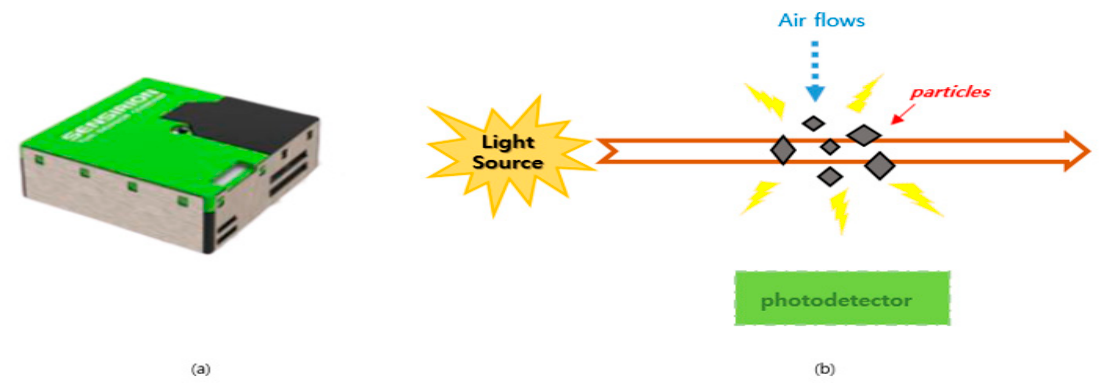
Figure 4. ICT-Particulate Matter Sensor (SPS 30), ( a ) optical sensor structure, ( b ) principle of optical sensor.